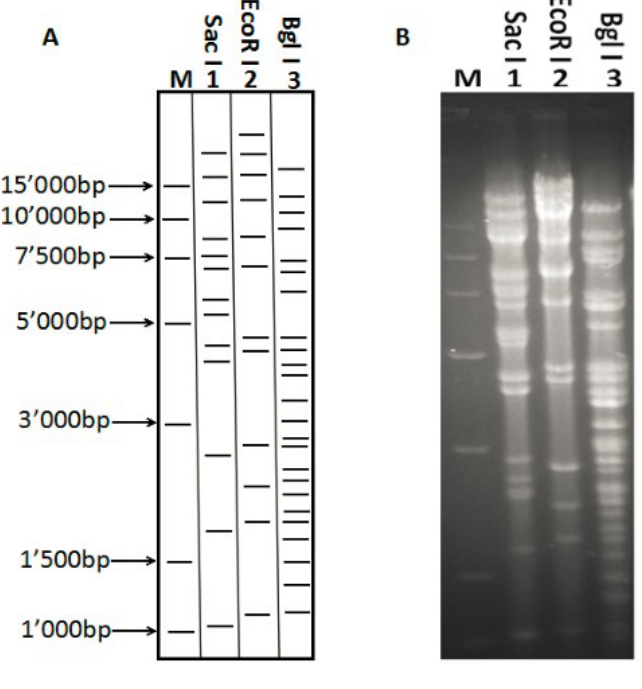
Figure 3. Restriction fragment analysis of pBAC-C-KCE. ( A ) The patterns corresponded exactly to the predictions based on the full C-KCE genome (KF263690.1). ( B ) pBAC-C-KCE was extracted and digested with Bgl I, EcoR I and Sac I and separated with a 0.8% agarose gel. The sizes of a molecular weight marker (M: DL15’000 bp, Transgen, beijing, china) were